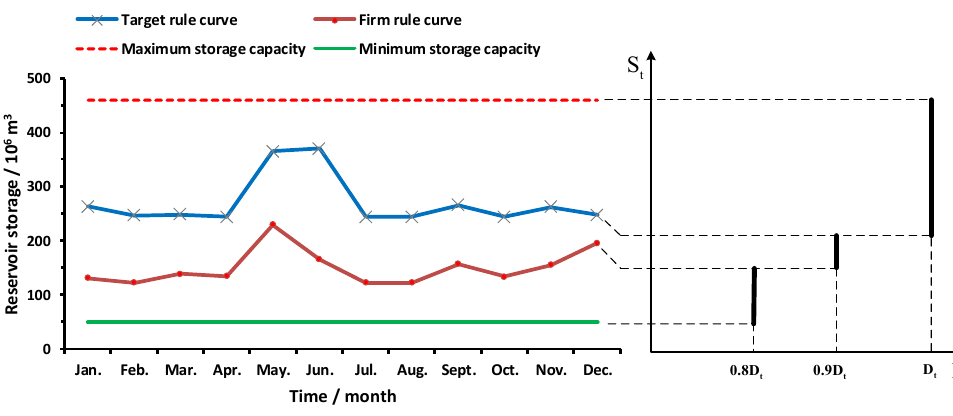
Figure 14. The operation policy obtained using the conventional rule curves.